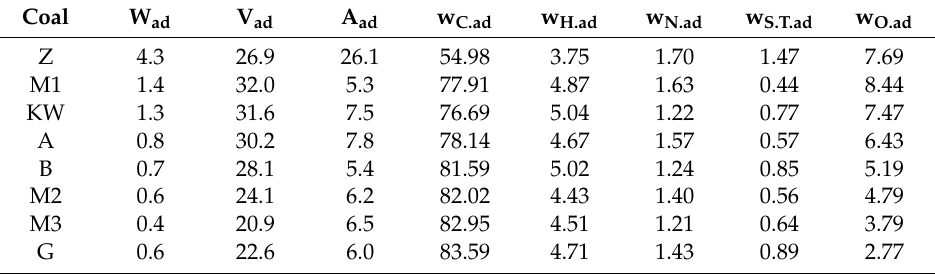
Table 1. Properties of coals used in thermogravimetric studies, wt